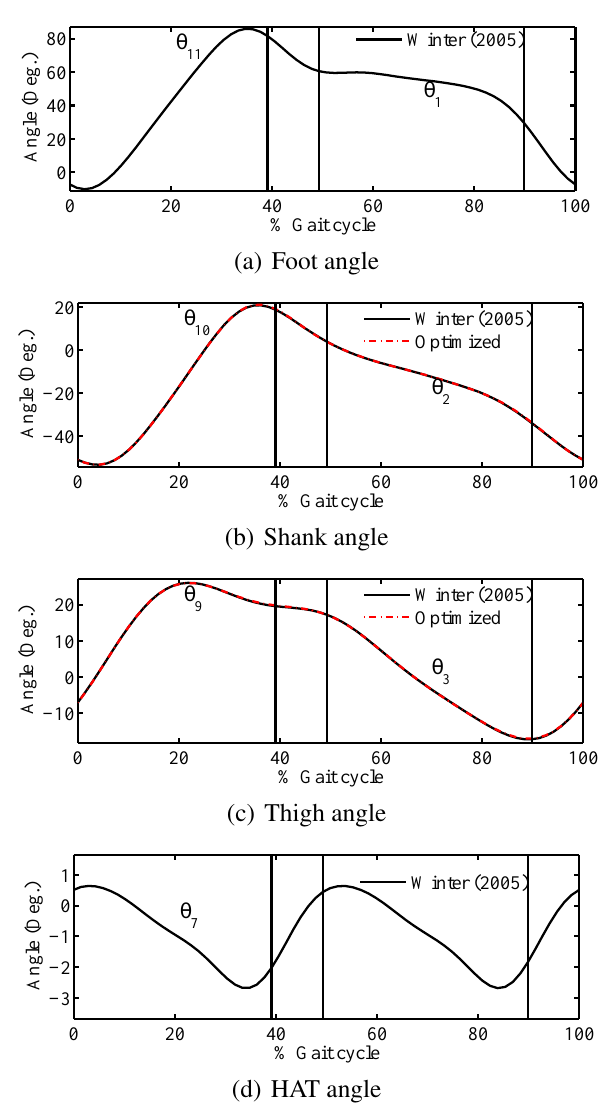
Figure 4. Sagittal plane kinematic data for full gait cycle (toe-off to toe-off) (Winter, 2005). (a) Foot, (b) shank, (c) thigh and (d) HAT angles. For (a) – (c) the data from 0 to 39% gait cycle indicate data for the swing leg and angles from 50 to 89% gait cycle indicate data for the stance leg in the SS phase.